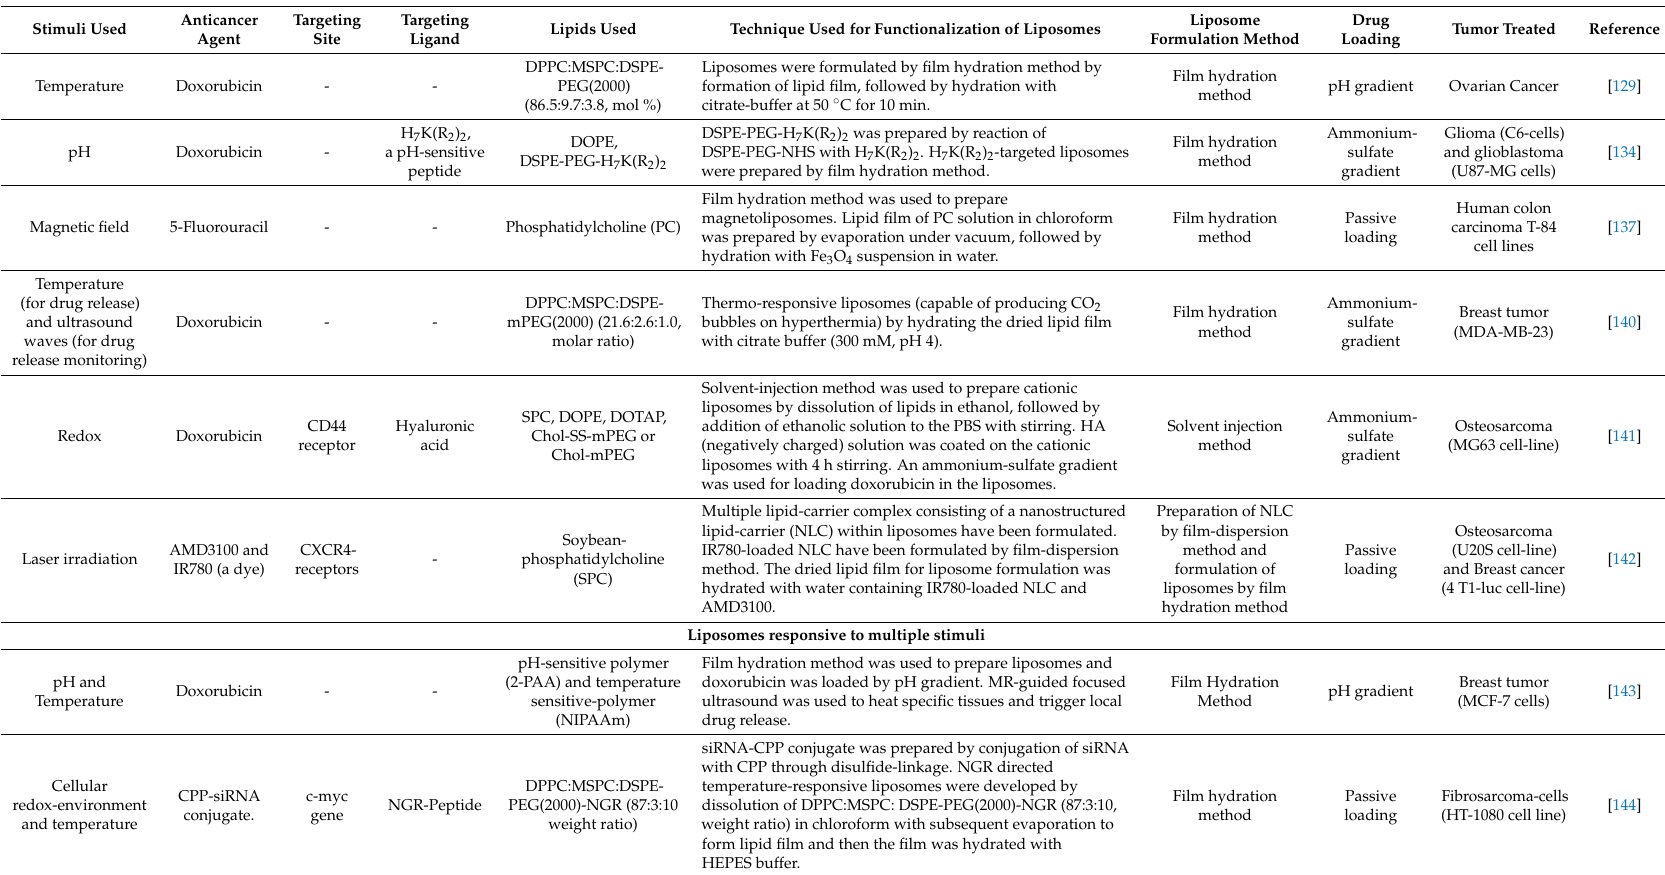
Table 2. Stimuli-responsive functionalized liposomes for enhanced delivery of anticancer agents at tumor